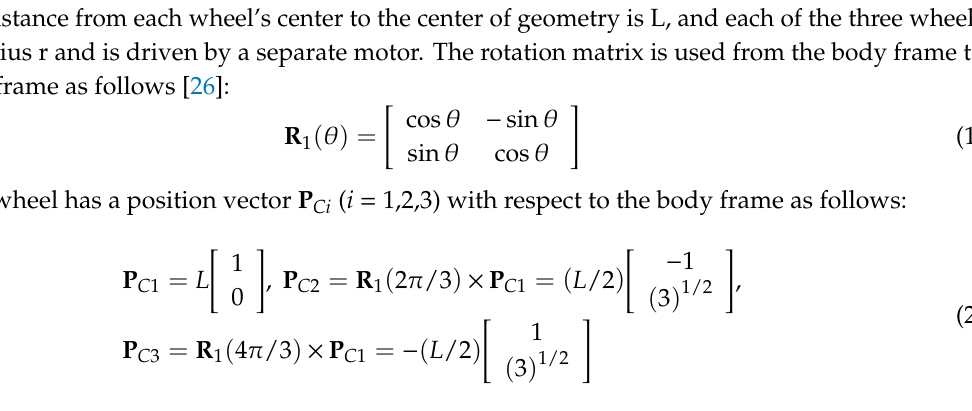
Figure 1. A three Omni-directional wheeled wheelchair configuration.